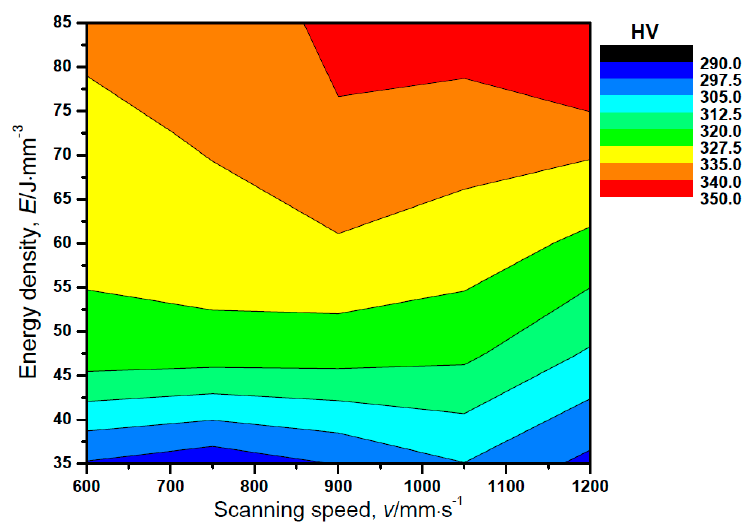
Figure 11. Vickers hardness contour map against scanning speed and energy density.